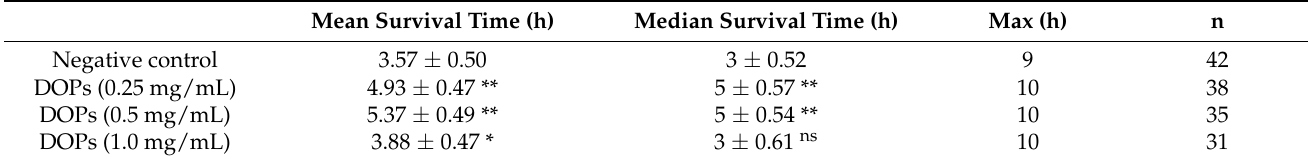
Table 3. The effects of DOPs on the lifespan of C. elegans under oxidative stress conditions. Mean Survival Time (h)